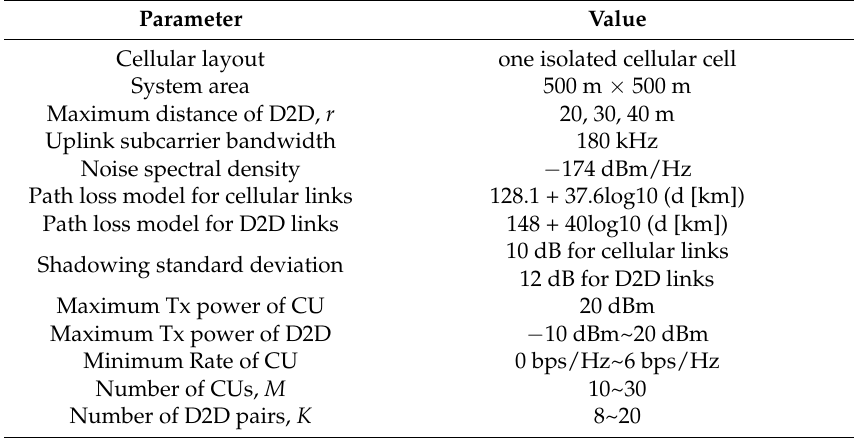
Table 2. Main Simulation